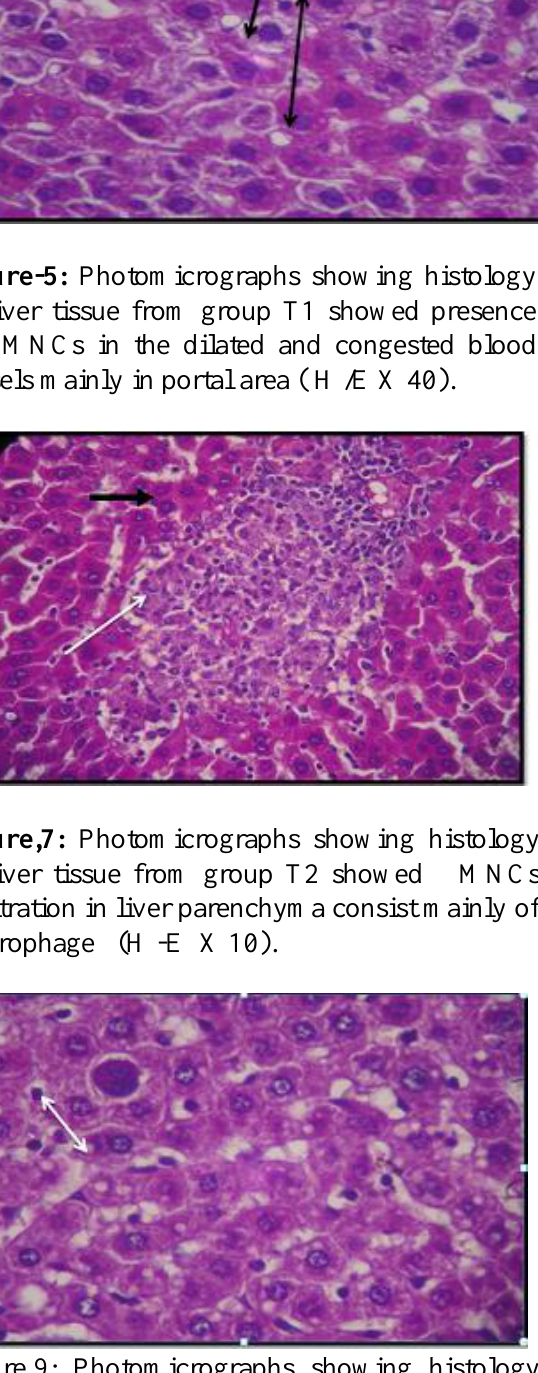
Figure,10: Photomicrographs showing histology of liver tissue from group T3 showed few inflammatory cells in blood vessels with proliferation of kupffer cells(H-E X 107